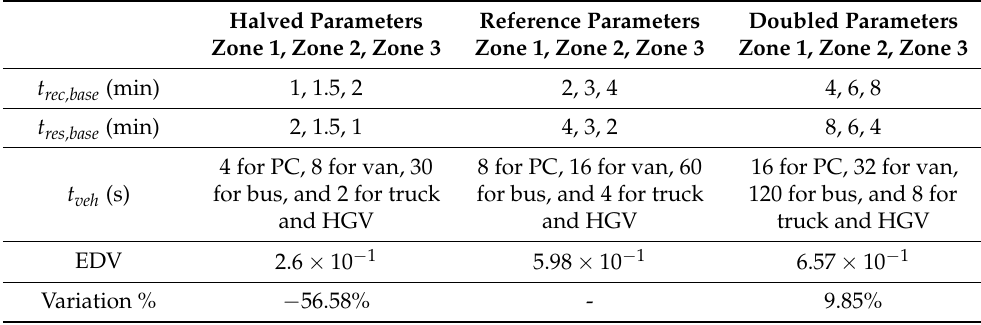
Table 8. The variation of EDV for halving and doubling pre-movement